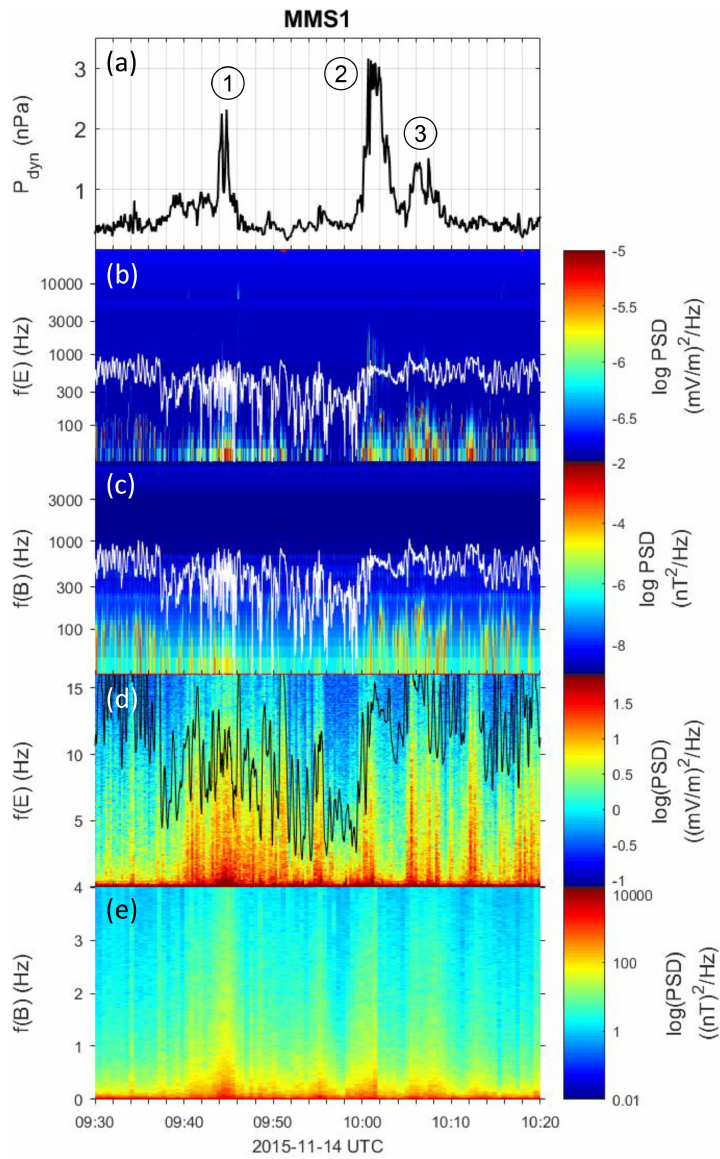
Figure 6. High- and medium-frequency wave activity. From top to bottom: dynamic pressure, on-board omnidirectional electric and mag- netic field power spectral density (with the electron cyclotron frequency indicated by the white line), omnidirectional electric and magnetic field constructed from the survey and slow survey data, respectively. For the electric field spectrogram, the local lower-hybrid frequency is indicated by the black